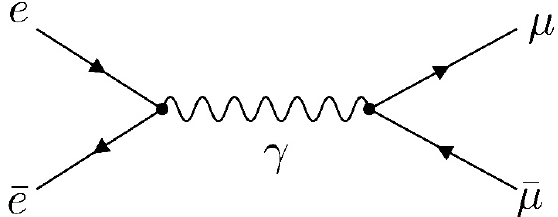
Figure 1. An example of a Feynman diagram of electron–positron (e¯e) annihilation. The diagram describes the transformation of an electron–positron pair into a muon–antimuon ( µµ ) pair. The interaction is mediated by a photon ( γ ) which is the interaction particle of the electromagnetic interaction. The direction of arrows determines whether it is a particle or an antiparticle. A defining property of every FD is that charges are conserved throughout the dia ‐ gram, meaning that the total amount of any charge (electromagnetic, weak, and strong charge) is the same on the left and on the right side of the diagram. In Figure 1, this can be straightforwardly checked for the electric charge, since the electron and the positron on the left have a total electric charge of zero, which is also true for the muon and the antimuon on the right side.